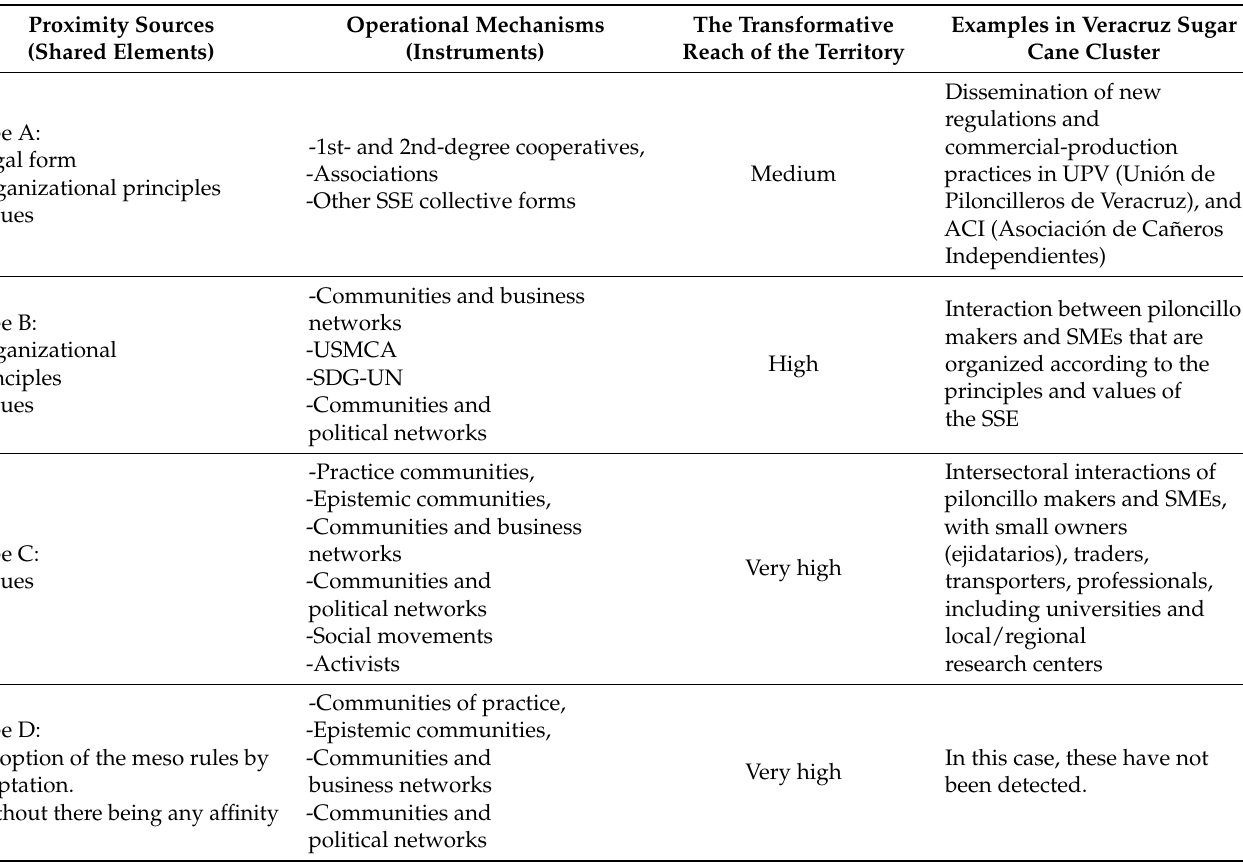
Table 4. Meso-rules diffusion mechanisms by